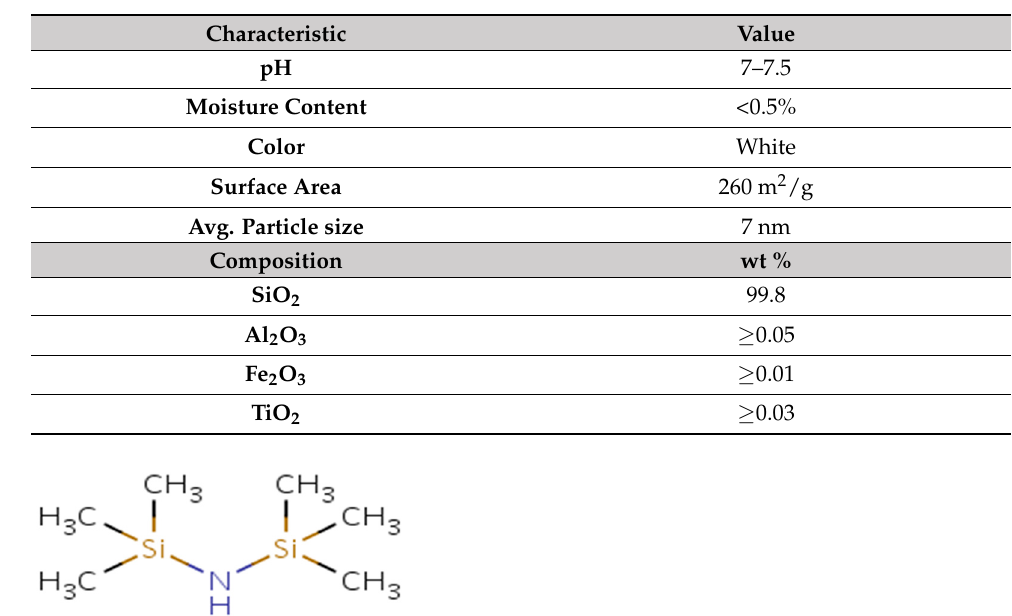
Figure 1. Chemical structure of HMDS.